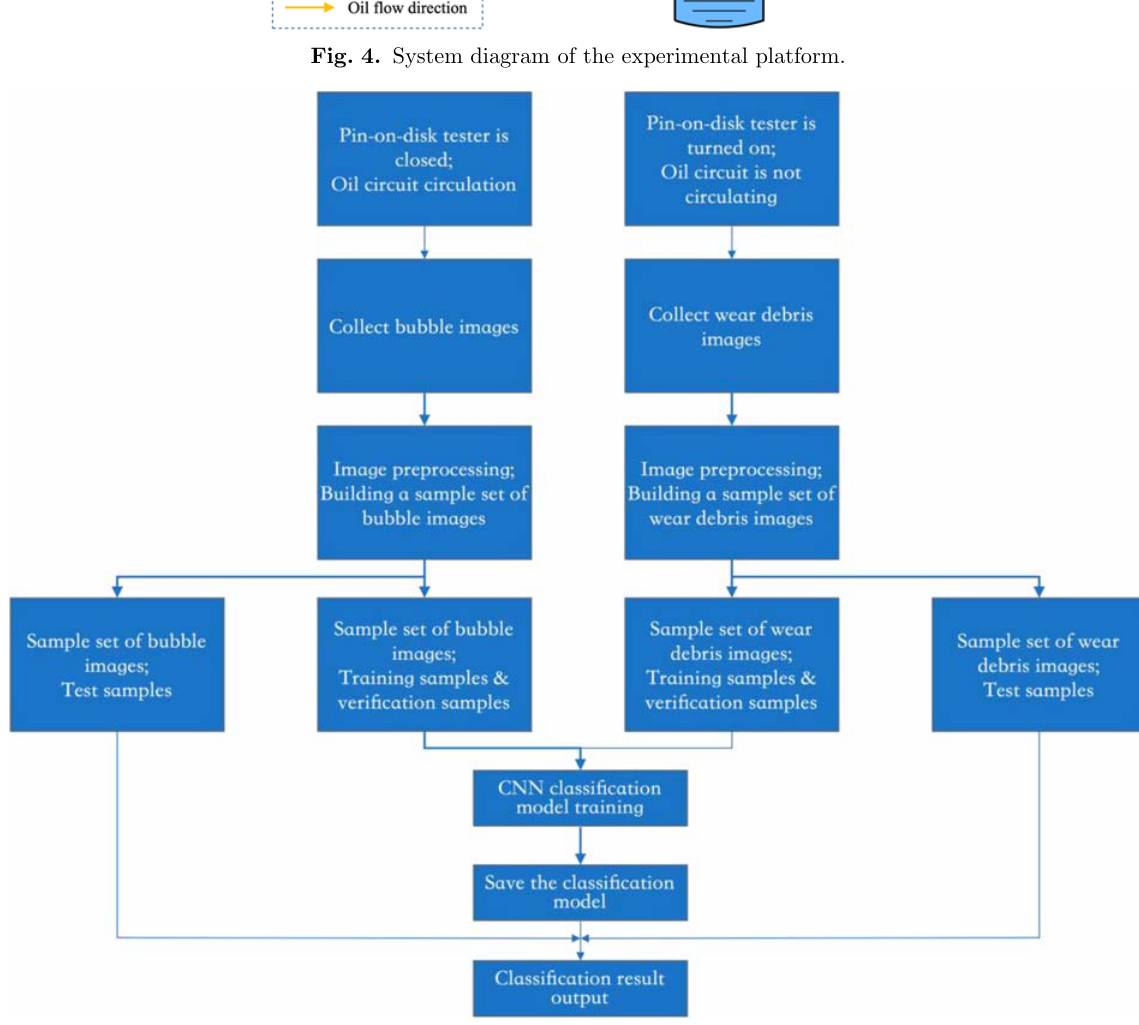
Fig. 5. Overall fl ow chart of debris and bubble image